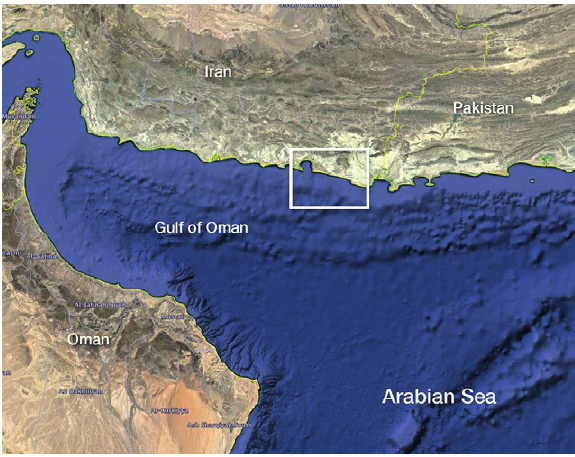
Fig. 1. – Map of the study area in the Iranian coastal waters of Gulf of Oman, Chabahar region (in the